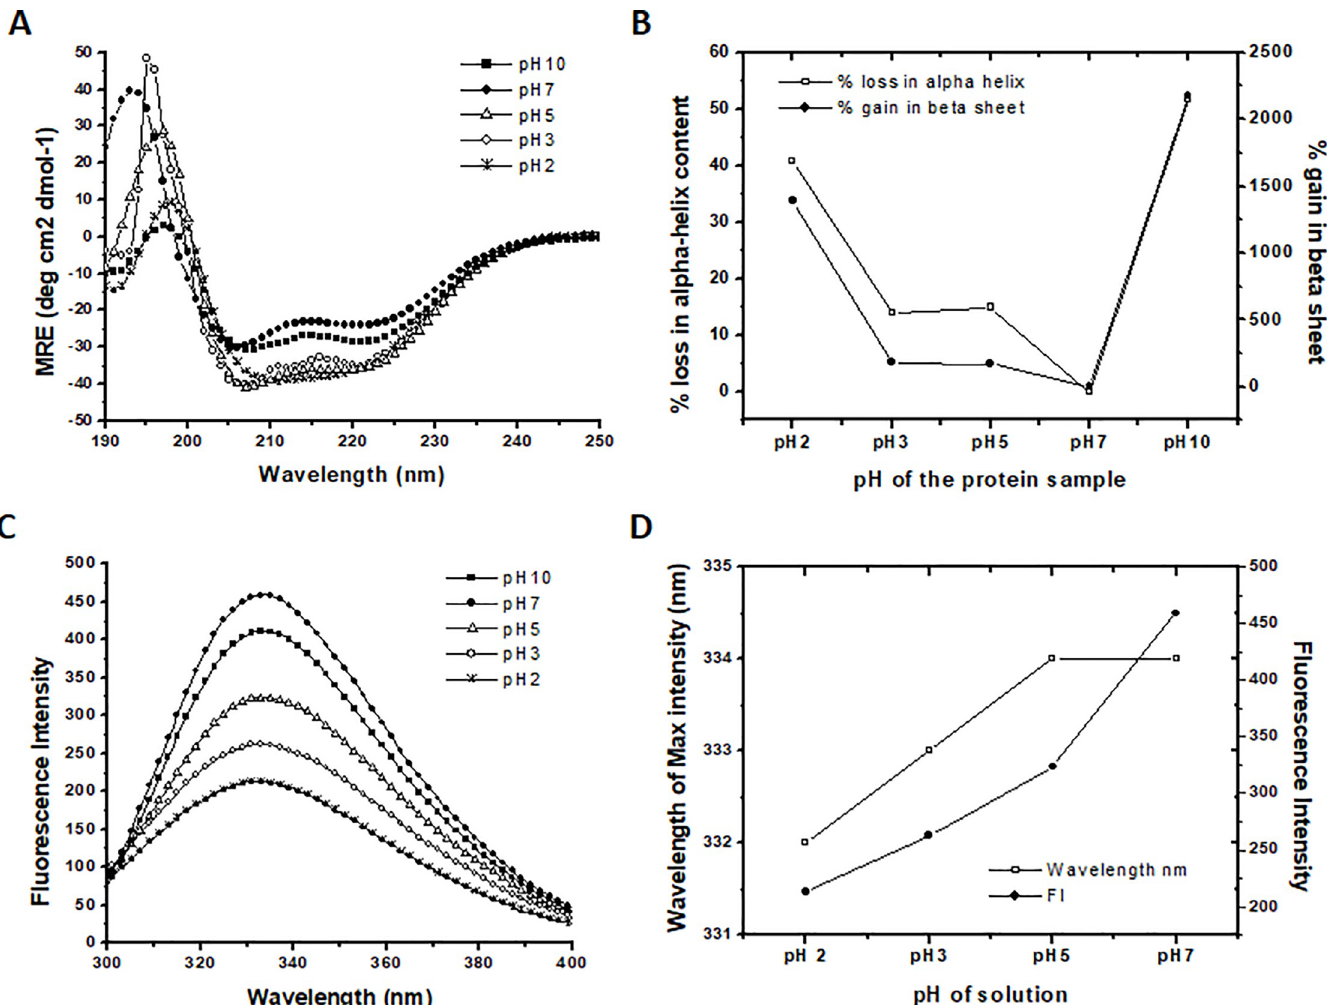
Fig 3. pH-dependent structural transition of Sus1. (A) Represent far-UV CD spectra, (B) represent the % loss of α -helix and % gain in β -sheets (C) represents the fluorescence emission spectrum and (D) represent the plot of fluorescence intensity and wavelength of maximum intensity at different pH. Native protein (pH-7) represented by closed circle (•) followed by protein samples at pH-2, 3, 5 and 10 represented by star ( ⁎ ), open circle ( � ), open triangle ( Δ ) and filled square ( ■ ) respectively. % loss of α -helix is represented by open square ( □ ) and % gain in β -sheets are represented by closed circle (•). Similarly, the wavelength of maximum intensity and fluorescence intensity is represented by open square ( □ ) and closed circle (•) respectively. The % α -helix and β -sheets were calculated using the K2D3 web server.